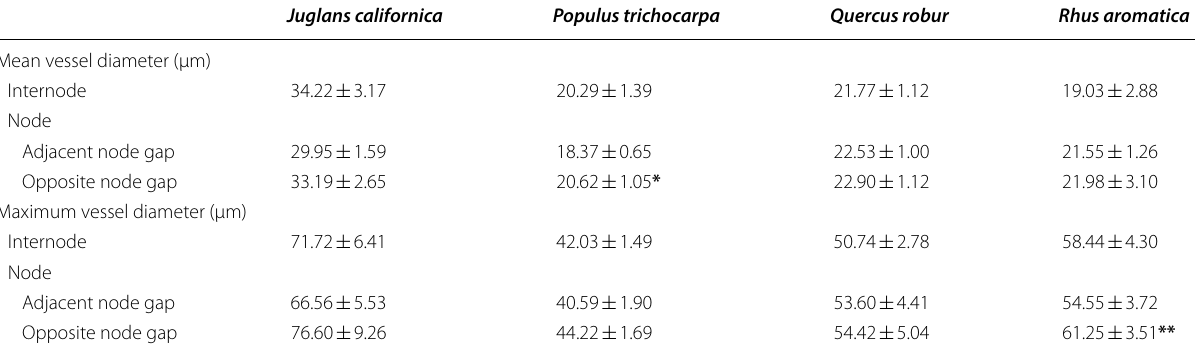
Table 2 Means ( 1 SE) for anatomical traits measured within nodes and internodes of four species, including mean ± and maximum vessel diameters from xylem in the internode, from adjacent to the node gap in the node, and from opposite of the node gap in the node